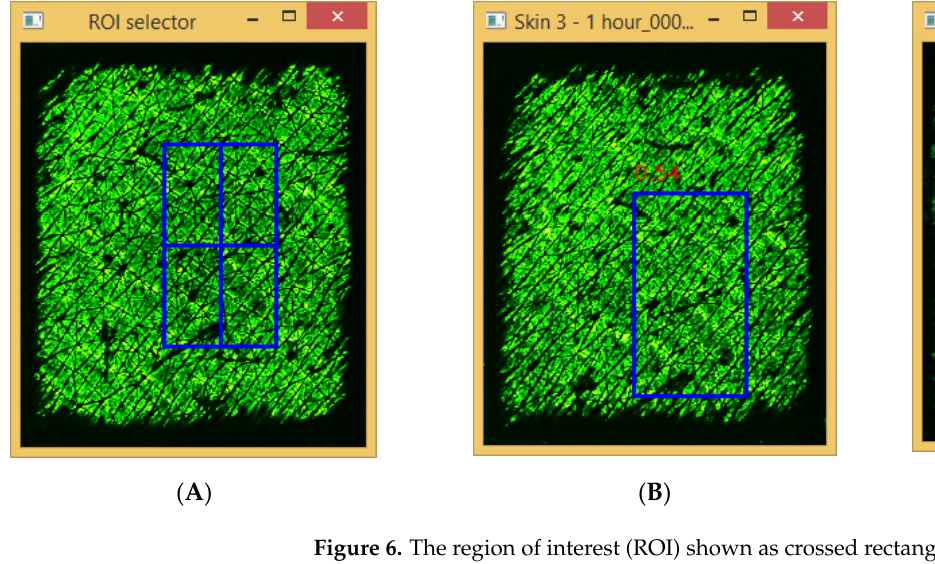
Figure 5. Epsilon permittivity images of four volar forearm test sites before, 1 h after, and 2 h after application of sunscreen. SPF 20, SPF 30, and SPF 50+ sunscreen was applied on three skin sites. The fourth skin site was used as a control.